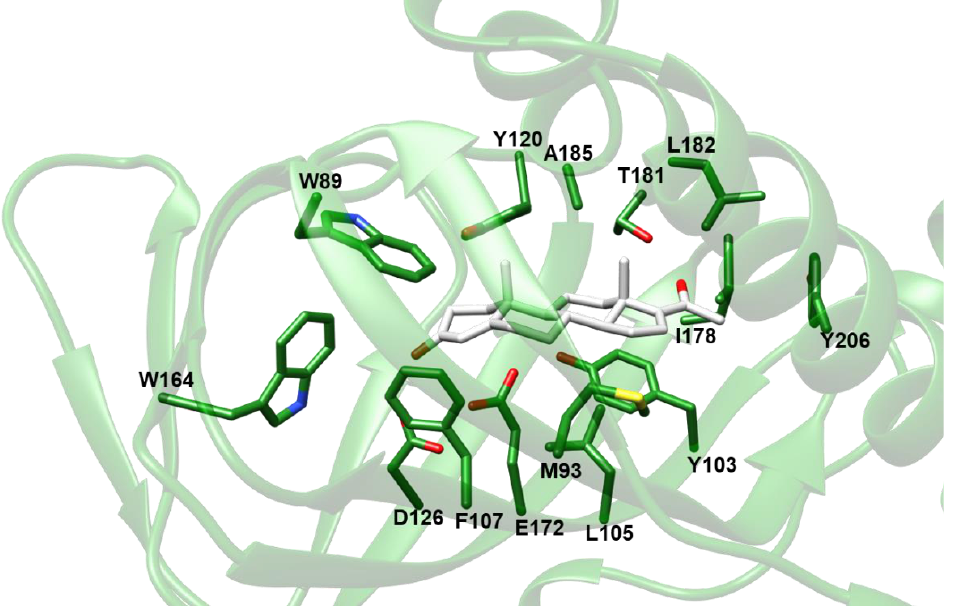
Figure 5. Molecular model of the complex between Hs σ1 -R and 16,17-didehydroprogesterone built by VINA. The protein is shown as ribbon and colored green. The ligand and the side-chains of residues at a distance ≤ 4.0 Å from the ligand are shown as sticks and colored by atom-type: N, O and S atoms are blue, red and yellow, respectively; C is green for the protein and white for the ligand. The only exception is V84, which was removed from the picture for clarity.